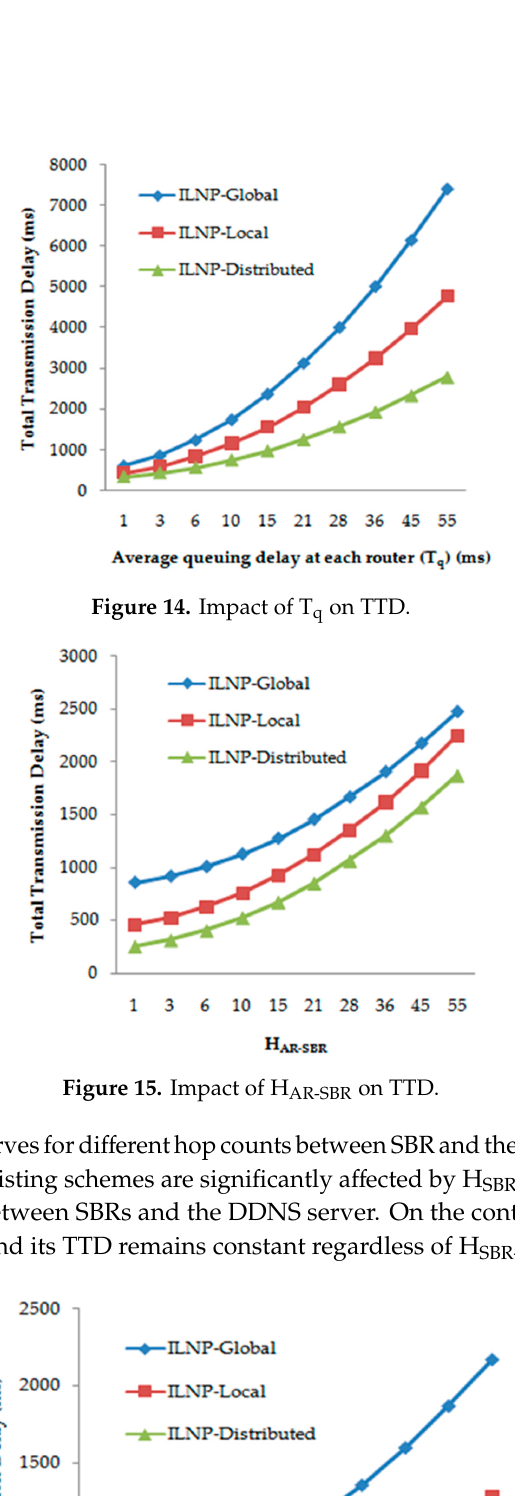
Figure 16. Impact of H SBR-DDNS on TTD.